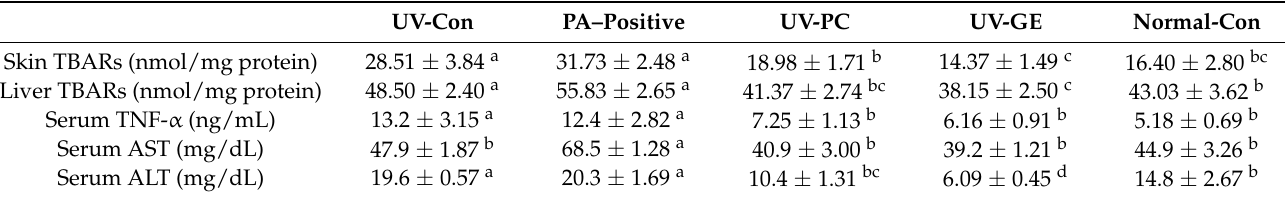
Table 2. Skin and liver damage.